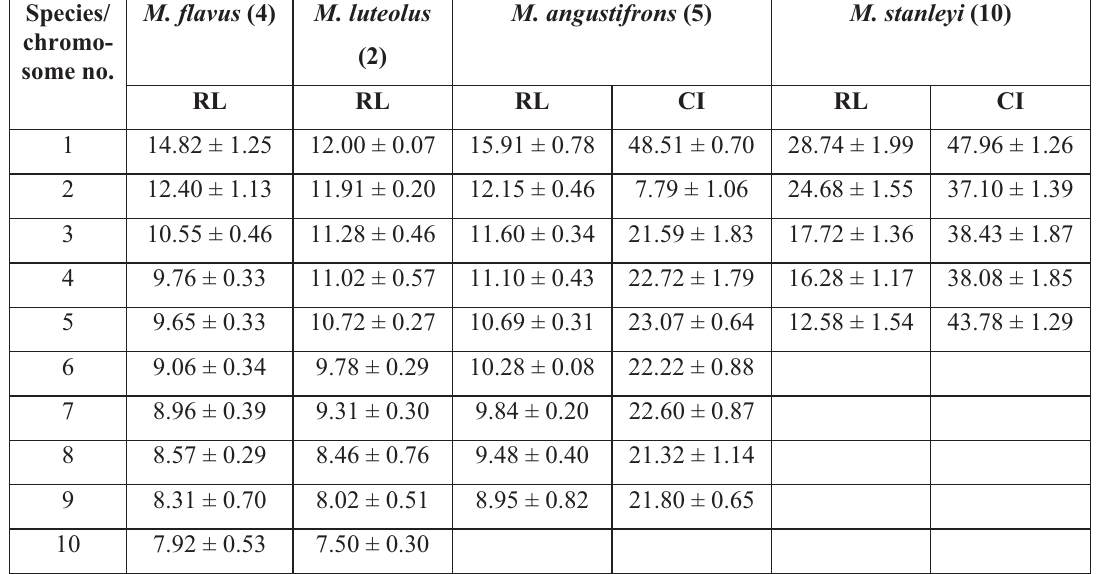
(Fig. 1, d, e). n = 10, 2n = 20. The karyotype